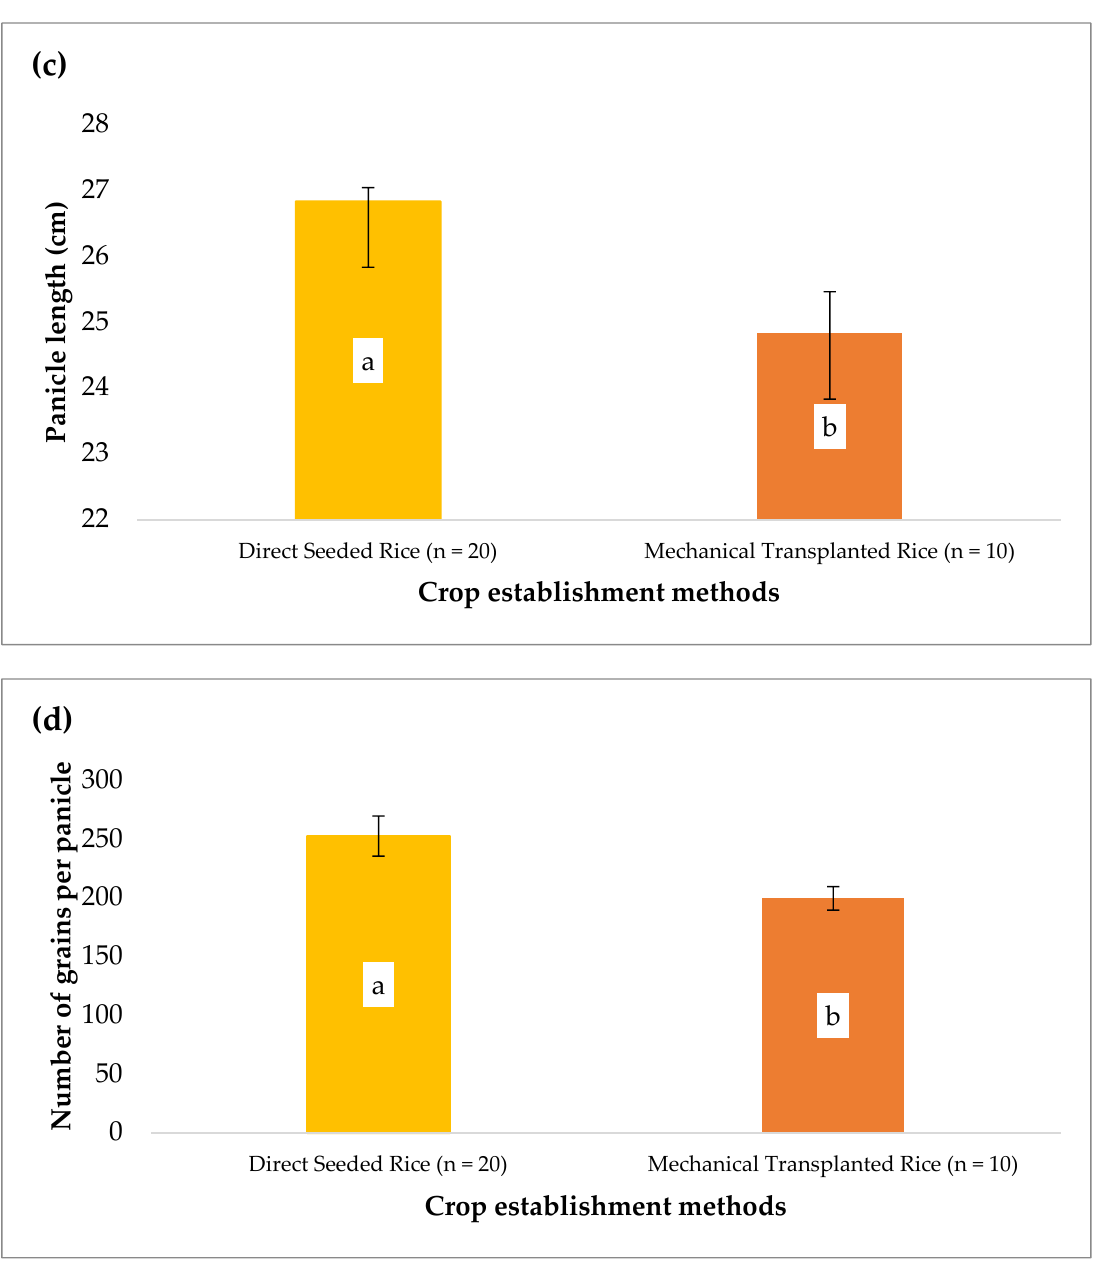
Figure 5 . Effect of crop establishment methods on ( a ) plant height at maturity; ( b ) effective tillers per square meter; ( c ) panicle length; and ( d ) the number of grains per panicle. Vertical bars for each column indicate standard deviation of the mean (for direct seeded rice n = 20 and in mechanically transplanted rice n = 10). Means of different land uses, followed by the different lowercase letters (a–b), are significantly different. Table 1. One-tail t -test of different growth and yield attributes and crop lodging of direct seeding and mechanically transplanted rice establishment methods.